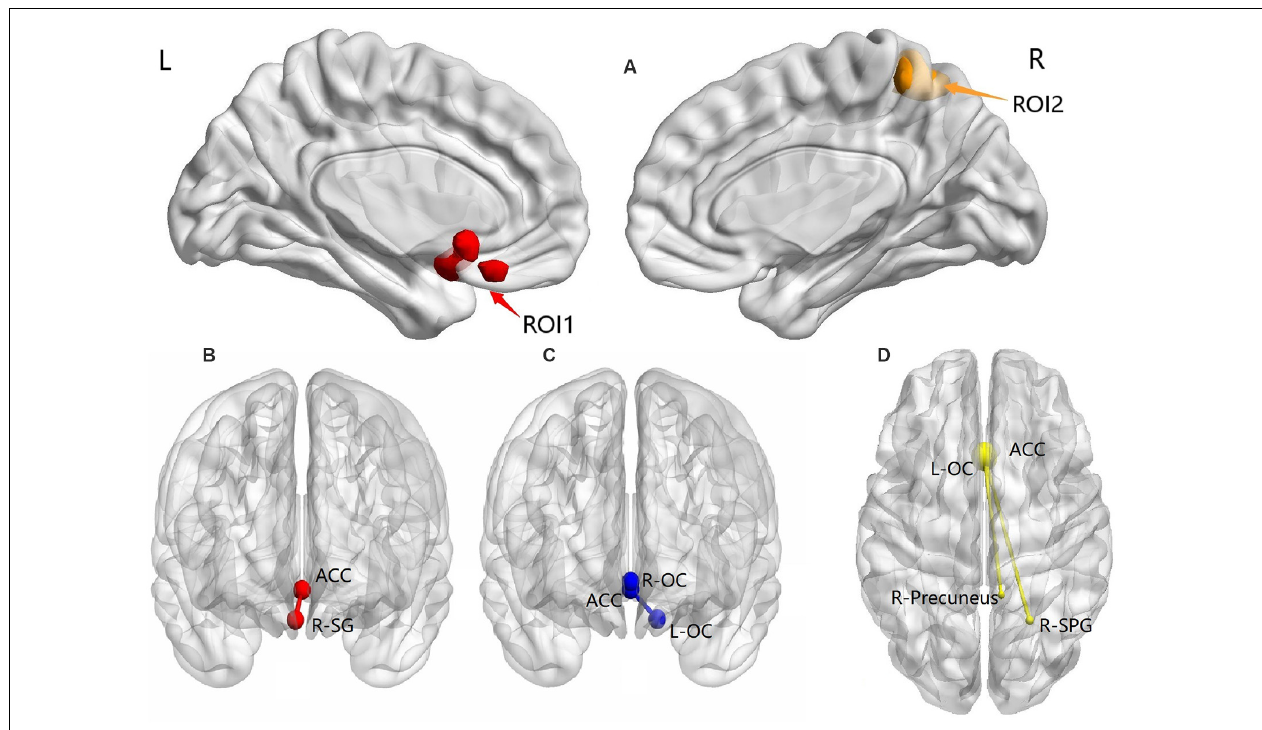
FIGURE 2 | ANOVA and post hoc analysis results for FC. (A) ANOVA among three groups; (B) comparison between the TDPD-NSD and TDPD-SD groups; (C) comparison between the HC and TDPD-SD groups; (D) comparison between the TDPD-NSD and HC groups. R, right; L, left; ROI1, left olfactory cortex, right straight gyrus; ROI2, right superior parietal gyrus and right precuneus; ACC, anterior cingulate gyrus; SG, straight gyrus; OC, olfactory cortex; SPG, superior parietal